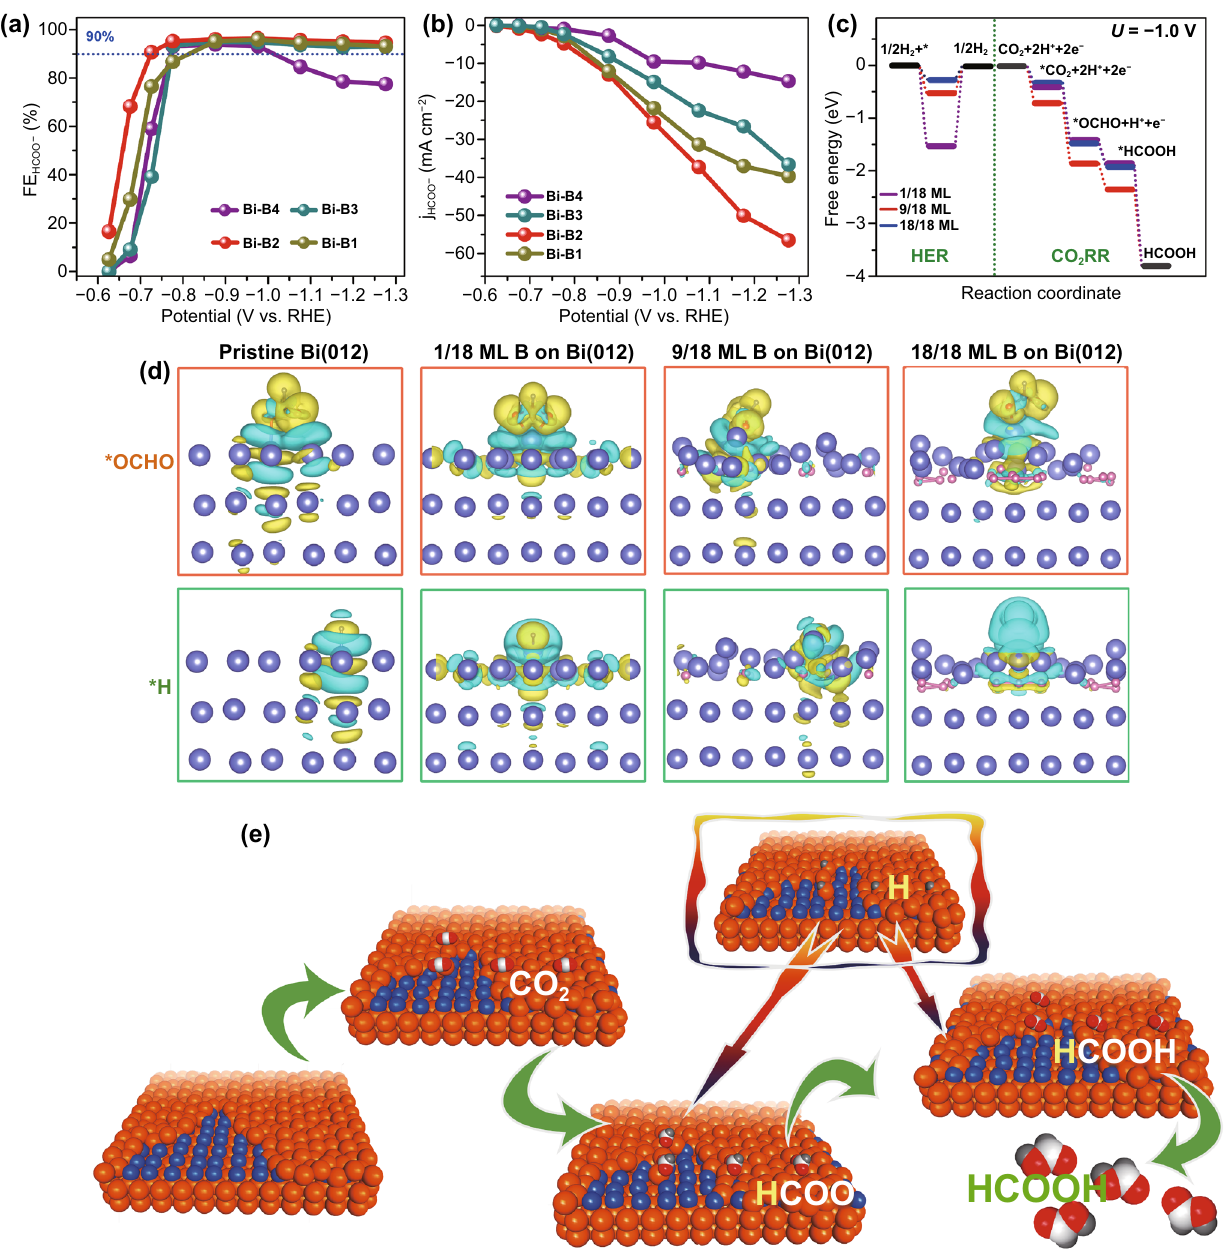
Fig. 5 a FE and b partial current density for formate generation for Bi‑B samples, c free energy diagrams of Bi with different B concentrations at U = –1.0 V and d side view of differential charge densities of *OCHO and *H adsorbed on different surfaces, regions of yellow and cyan denote electron accumulation and depletion, respectively. Blue, pink, brown, red, and pale balls represent Bi, B, C, O, and H atoms, respectively (The value of isosurface is 0.0005 e Å −3 ). e Schematic illustration for the H + promoted hydronation process of CO 2 to formate on Bi surface with B